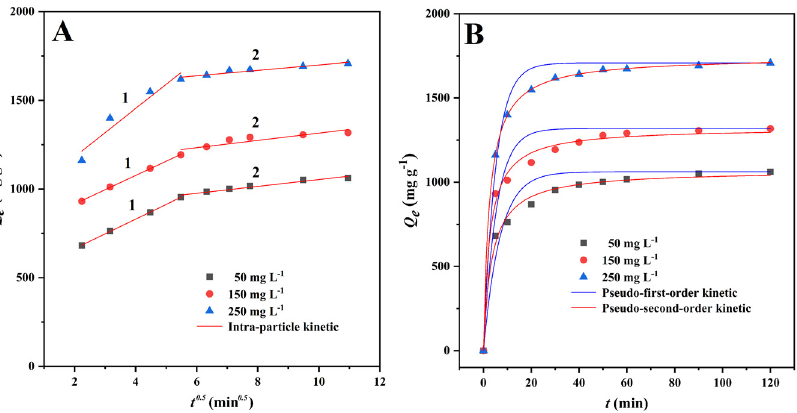
Figure 4. Non-linear fitting of MG adsorption kinetics onto CMBC-4-700-30 at different initial concentration at 303 K. ( A ) Intra-particle diffusion model and ( B ) pseudo-first-order and pseudo-second-order kinetics.